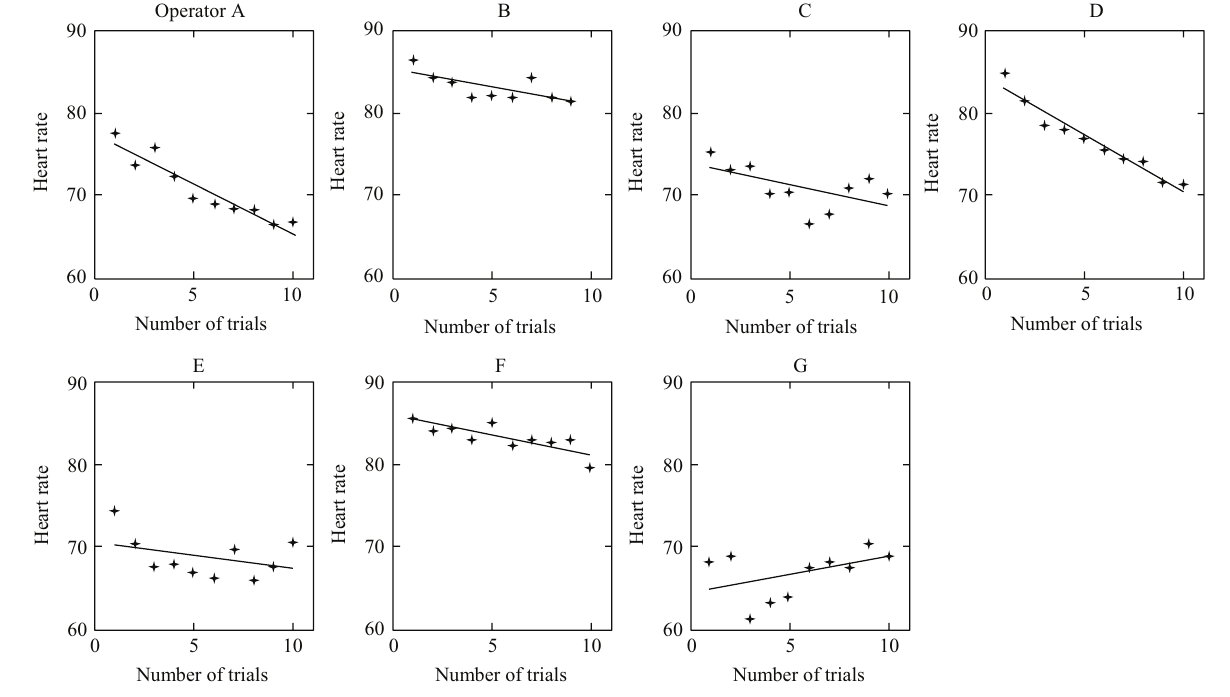
Figure 11: Transition of HR of all